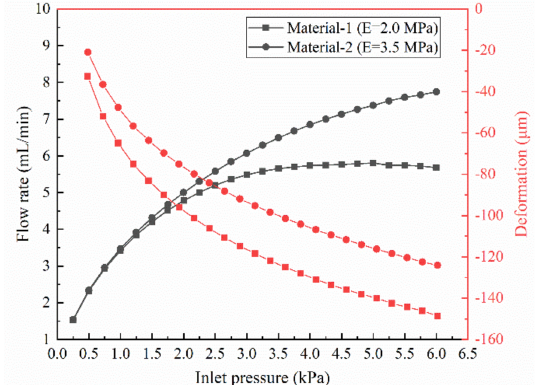
Figure 12. Flow rates and maximum deformation of the membrane with various material properties with n = 4 and L = 1000 µ m.